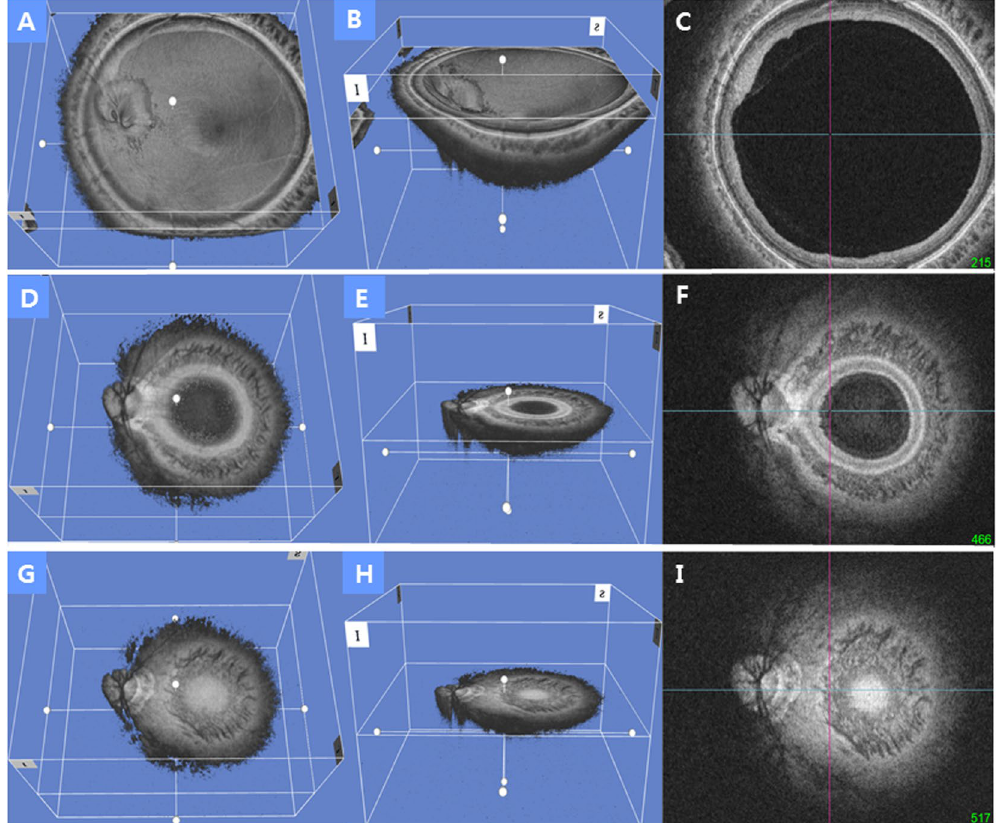
Figure 1. Representative three-dimensional tomogram of the posterior pole by swept-source optical coherence tomography. ( A ) Section of the eyeball on the nasal border of the optic disc. ( B ) Oblique view of the same section as A. ( C ) En face view of the same section as A. ( D ) Section of the eyeball on the temporal border of the optic disc. The displayed section is moved in the posterior direction from A. ( E ) Oblique view of the same section as D. ( F ) En face view of the same section as D. ( G ) Section of the eyeball on the posterior pole. The interface of Bruch’s membrane in the image appears as a hyper-reflective round plane that is surrounded by the choroid, indicating the deepest point of the eyeball (DPE) of the posterior retinal contour. The displayed section is moved in the posterior direction from D. ( H ) Oblique view of the same section in G. ( I ) En face view of the same section as G. This interface was defined as the DPE of the posterior pole